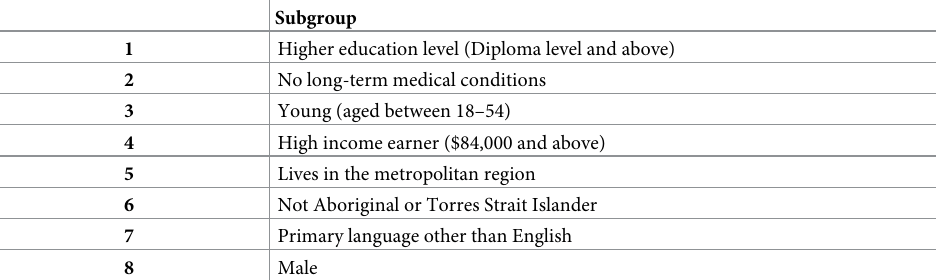
Table 2. Subgroup order of likelihood to utilise mobile health